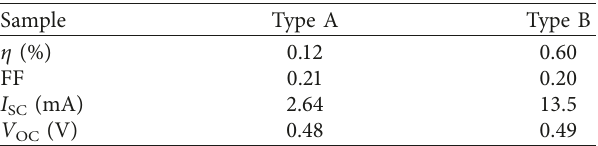
Figure 8: Measured I-V characteristics of our samples. Table 1: Performance of our